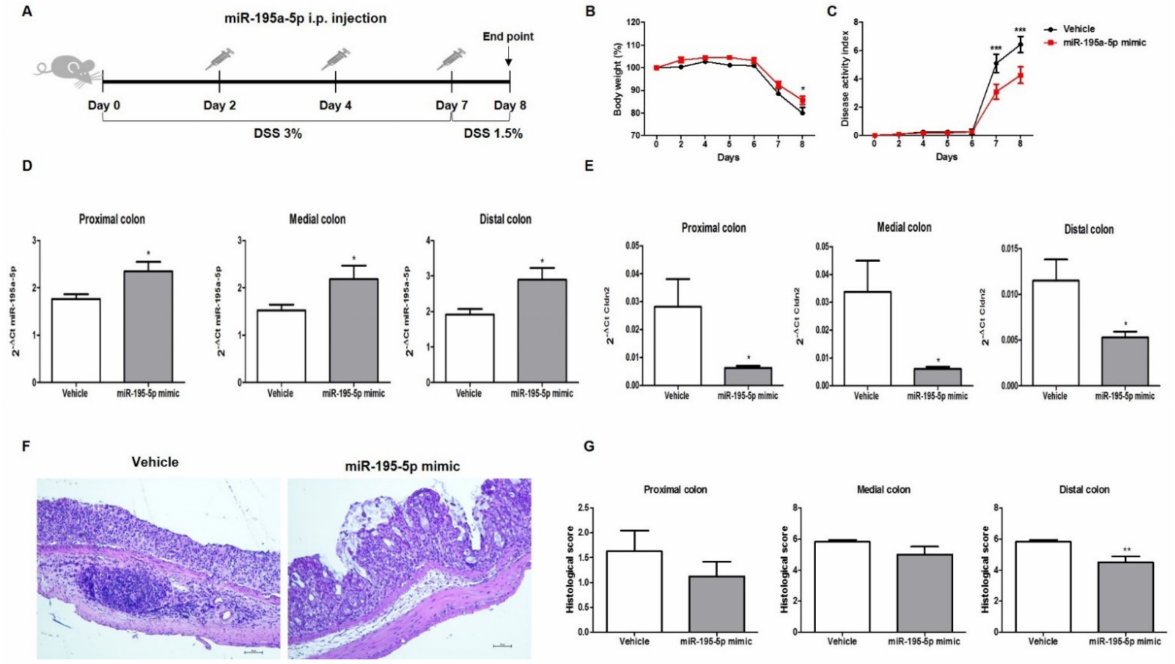
Figure 6. miR-195-5p mimic treatment reduces the intestinal inflammatory response in DSS- induced colitis. ( A ) Schematic diagram of DSS-induced colitis and miR-195-5p administration (n = 8 mice/group). After DSS treatment of mice, body weight loss ( B ) and disease activity index ( C ) were assessed during treatment in each group. ( D ) miR-195-5p expression levels by Real-time PCR in all colon portions (proximal, medial and distal) of treated mice compared to vehicle mice. ( E ) Cldn2 expression levels by Real-time PCR in all colon portions (proximal, medial and distal) of treated mice compared to vehicle mice. ( F ) Representative images of hematoxylin and eosin staining of distal colon tissue from each group taken at 10 × magnification. Scale bar 10 µ m. ( G ) Histological score of treated and control mice in all colon portions (proximal, medial and distal). * p < 0.05, ** p <